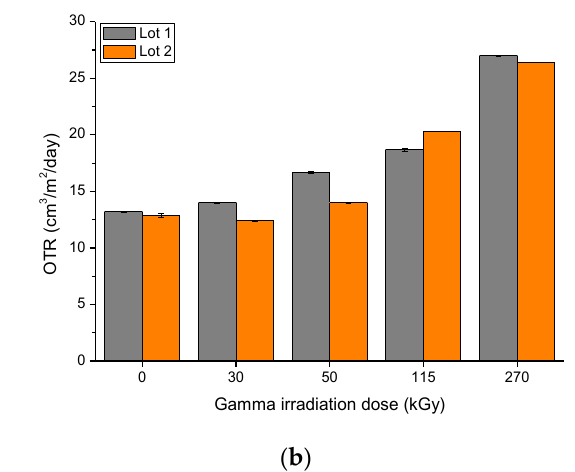
Figure 5. ( a ) WVTR and ( b ) OTR of EVA/EVOH/EVA multilayer film according to the γ-irradiation dose. Reproduced from [34] with the permission of Journal of Applied Polymer Science.